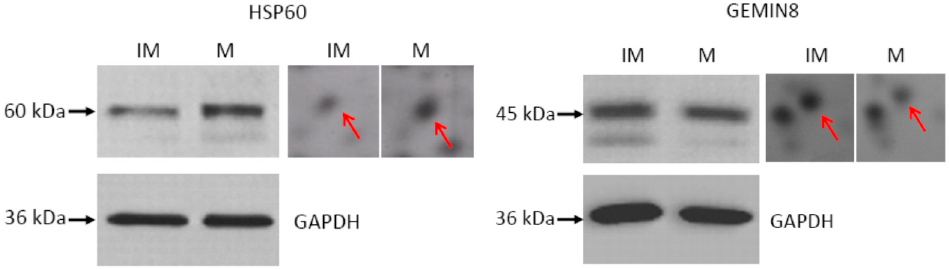
Figure 3. Validation of HSP60 and GEMIN8 proteins by Western blotting. IM, immature oocytes; M, mature oocytes. GAPDH was used as a loading control. The locations of HSP60 protein and GEMIN8 protein on 2-DE images were denoted by the red arrows.